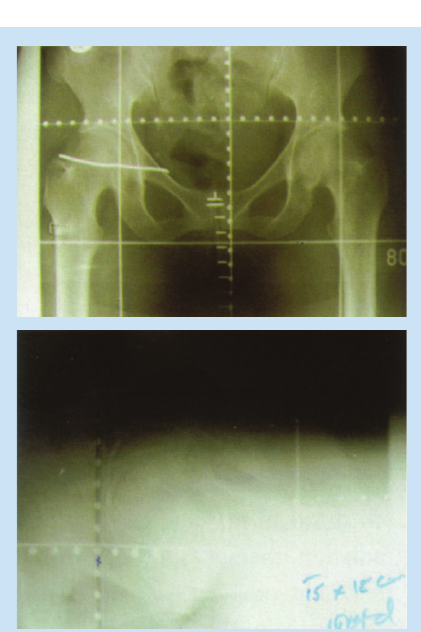
Fig. 2. Simulator films: AP view/lateral view show- ing both the external wire and the internal obtura- tor.